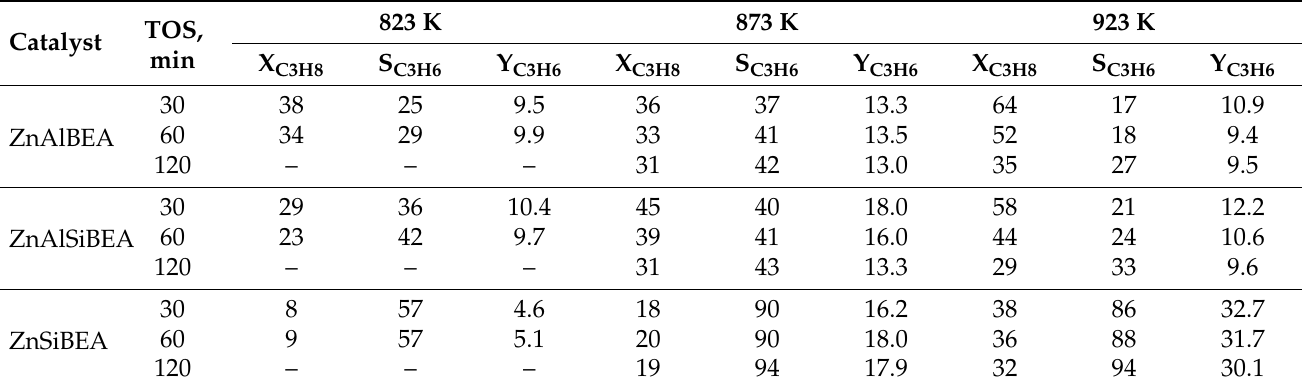
Table 5. Indices of the propane dehydrogenation in the presence of CO 2 on Zn-BEA catalysts for different